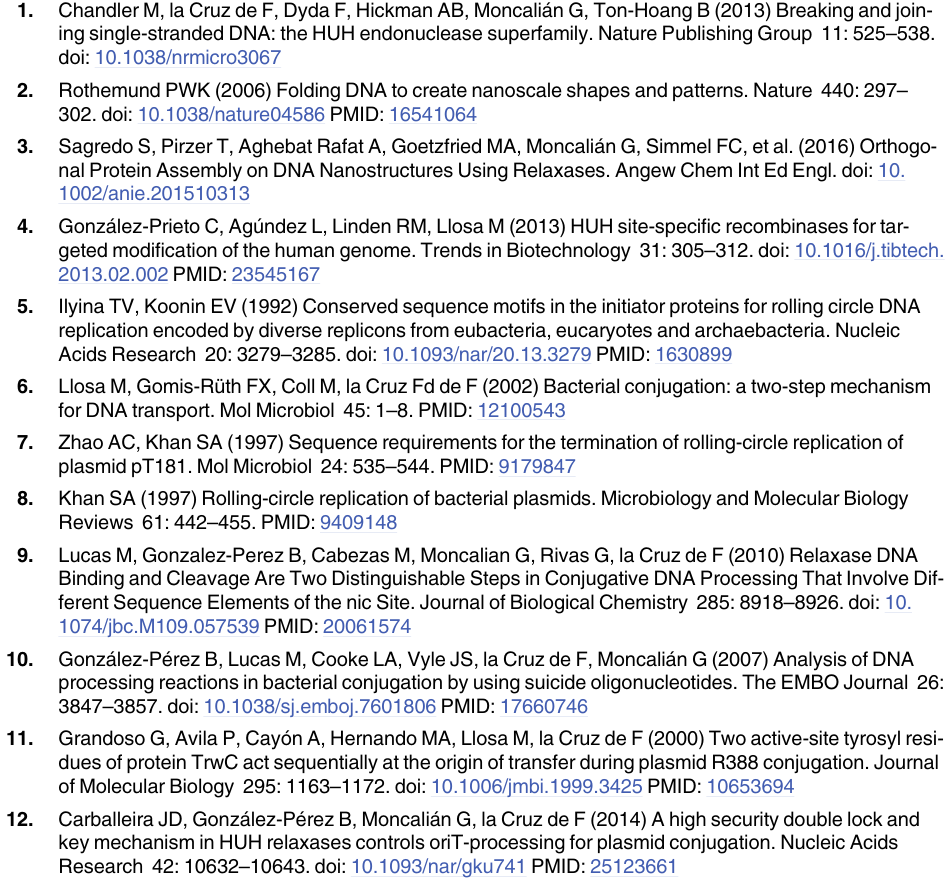
S8 Fig. Alignment of the synthetic oriT based on Rep and reverse-like nic sites. The four inverted repeats (IR to IR ) are highlighted and their sequences underlined. New IR 1 4 obtained in Rep-like and reverse plasmids are shown by orange arrows. The nic site is indicated with a yellow triangle. Stars show point mutations included in some of the R388 synthetic plas- mids to create BglII , BamHI , KpnI and PstI restriction sites.